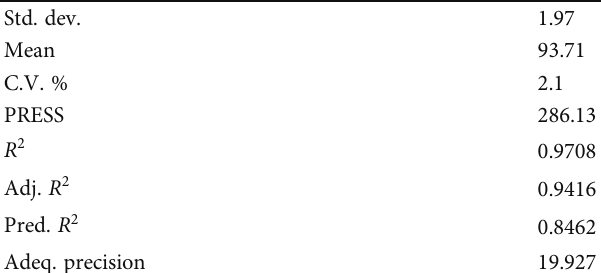
Table 5: Quadratic model for adsorption of Congo red dye on breadfruit leaf biochar adsorbent: standard fi t statistics. Std.